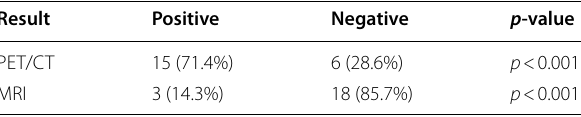
Table 2 Summary results of instrumental methods examined (PET/CT and